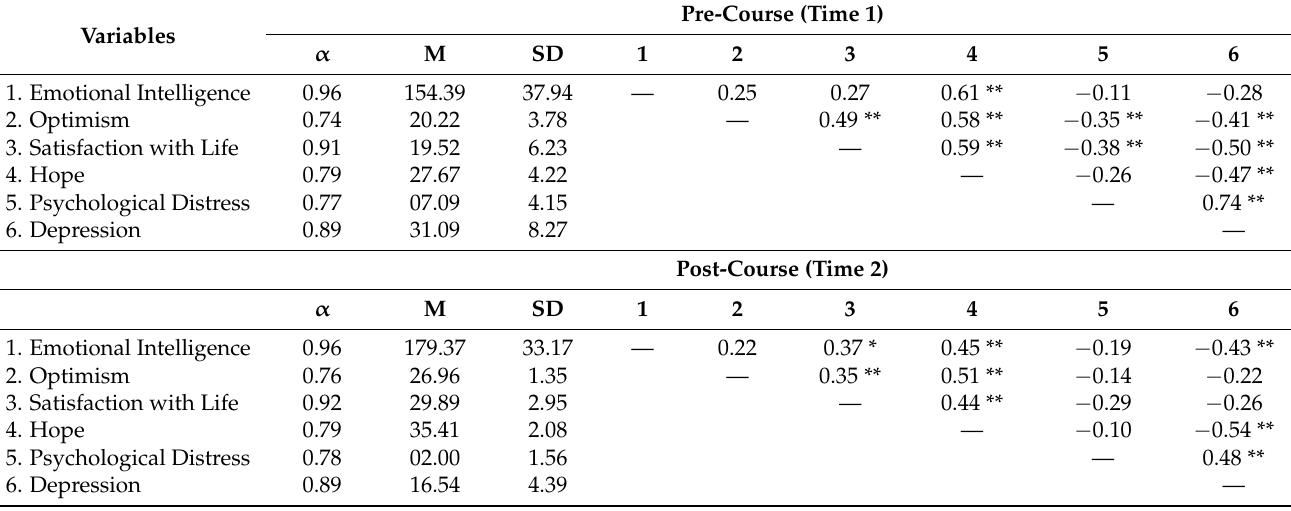
Table 4. Reliability coefficients, means, standard deviations, and correlations (Study 2).